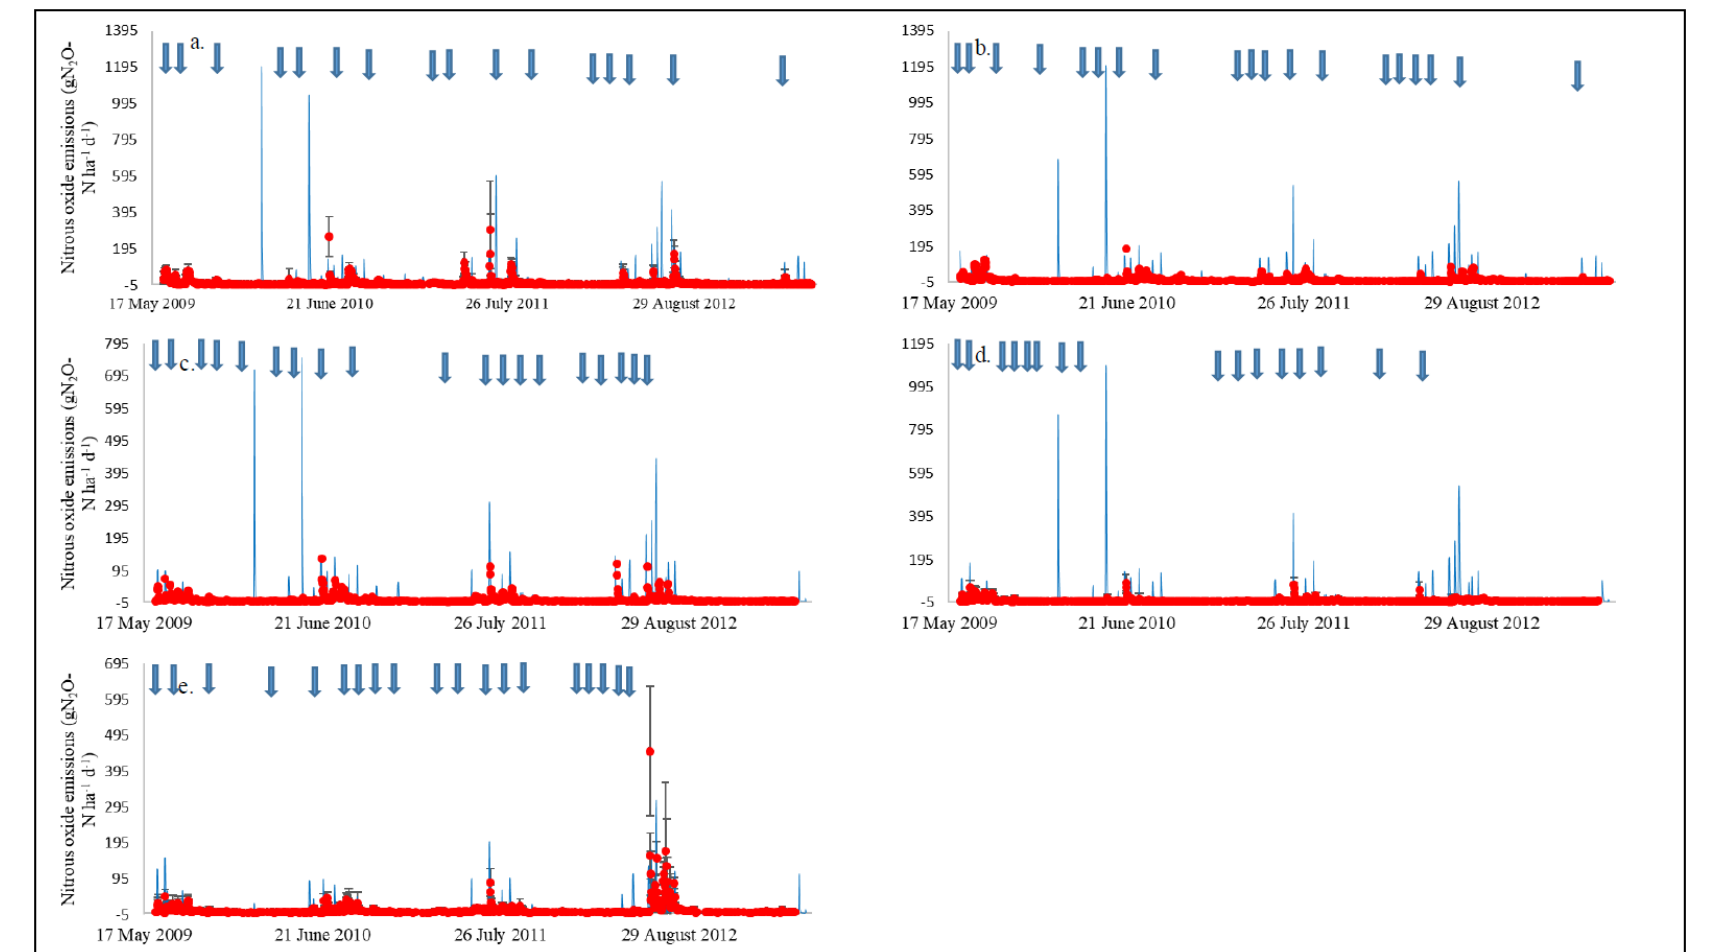
Figure 4. Field observed ( ● ) and DNDC simulated (line) daily N2O fluxes (gN2O-N ha-1d-1) for the conventional winter wheat-summer maize double-cropping system (Chem. W/M; a.), optimized winter wheat-summer maize double-cropping system (Opt. W/M; b.), winter wheat-summer maize-fallow-spring maize system (W/M-M; c.), winter wheat-summer soybean-fallow-spring maize system (W/S-M; d.), and spring maize system (M; e.) over the experimental period from June 2009 to June 2013. Blue arrows show time of application of N fertiliser.